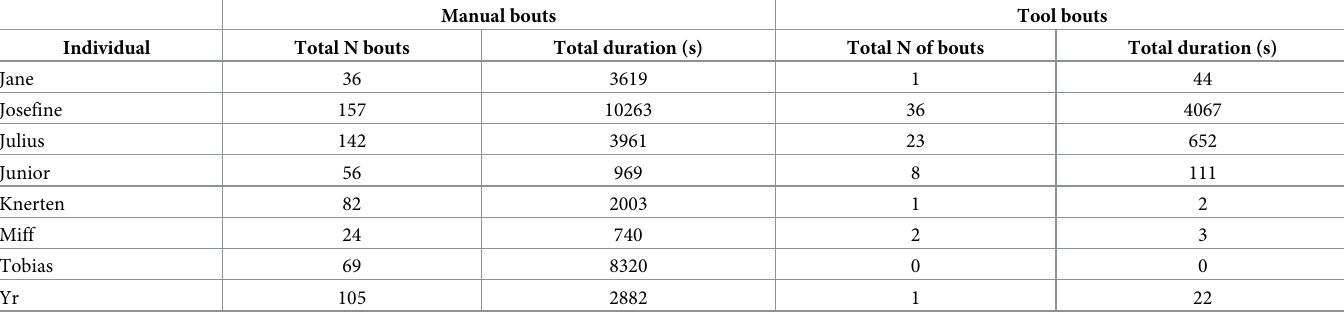
Table 3. Total individual bout counts and total bout durations in seconds of the manual and tool excavating bouts. The data correspond to the observations made during the Compacted Soil Condition of Experiment 2. Manual